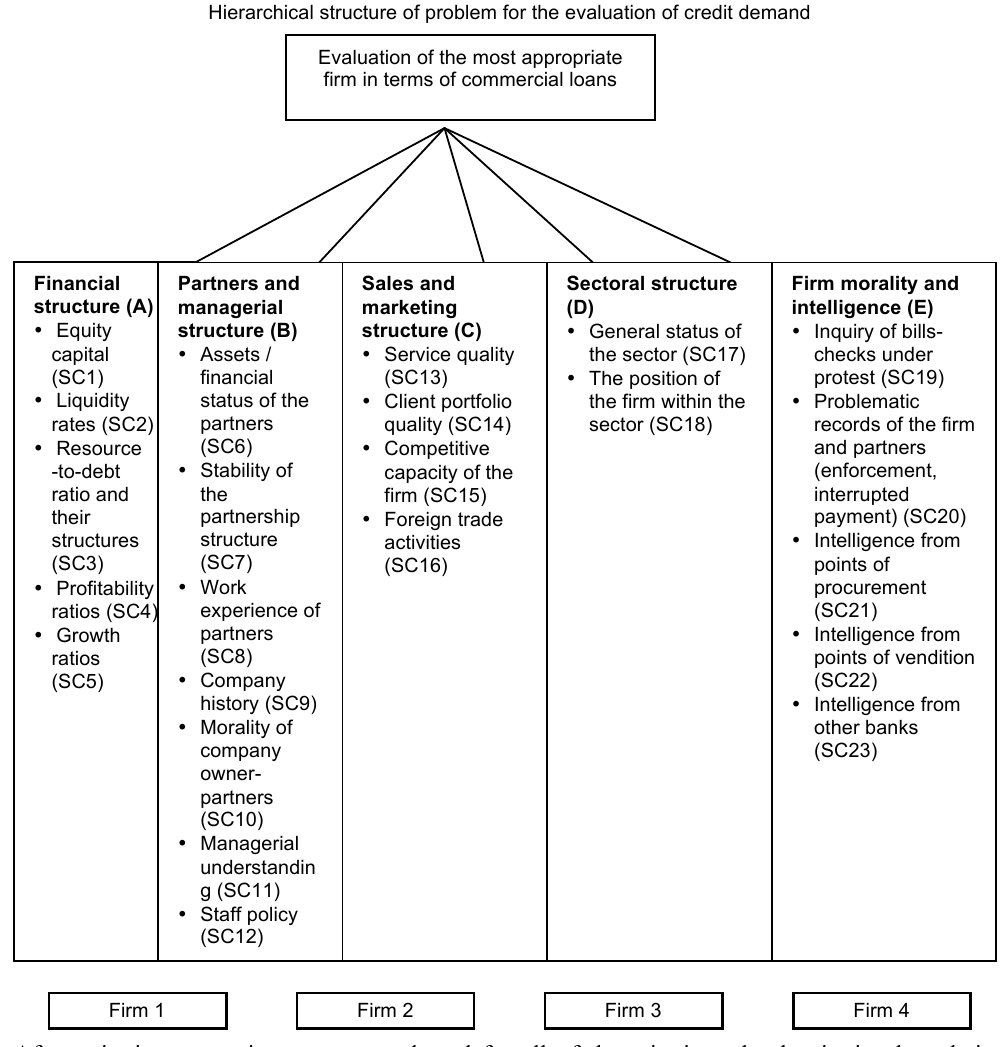
Hierarchical structure of problem for the evaluation of credit